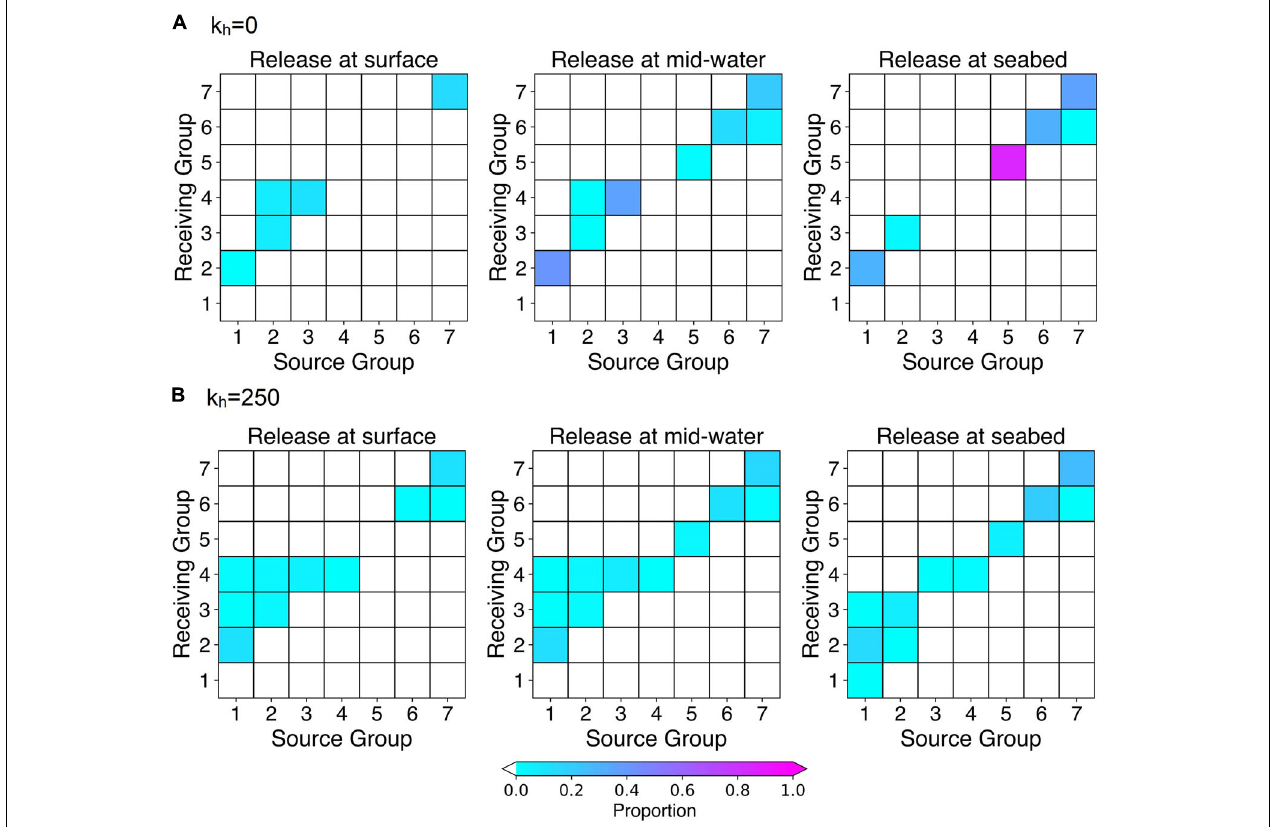
FIGURE 4 | Results of particle tracking simulations using long-term averaged ocean currents from July after a 2-week drift duration for releases from the surface, mid-water depths and the seabed. Connectivity matrices showing the proportion of modeled particles released from each of the occupied grid cells in each of the seven Groups (Source) passing over or terminating in another occupied grid cell in another Group (Receiving Area). Diagonal cells indicate particle retention within the occupied cells within each Group. (A) when k h = 0 and (B) when k h = 250 m 2 s − 1